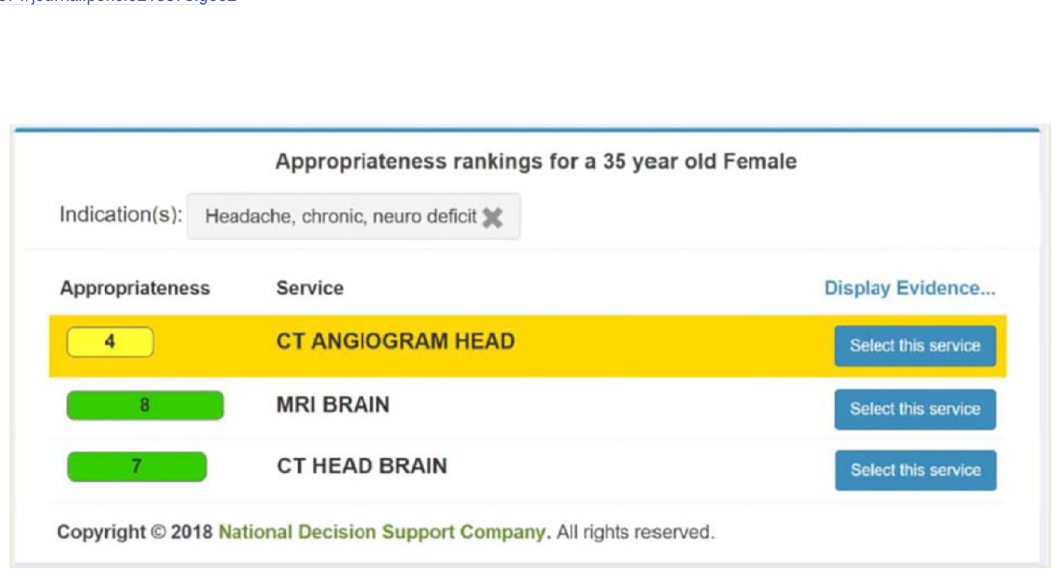
Fig 3. Example, best practice alert (BPA). Note: Reprinted under a CC BY license, with permission from the National Decision Support Company, original copyright 2018.